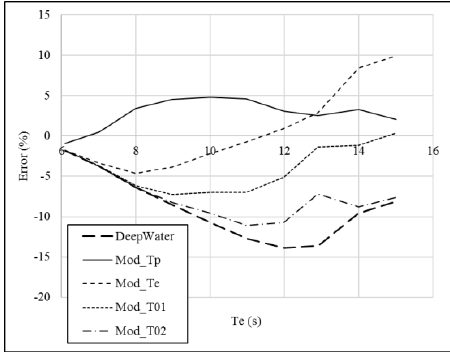
Figure 19. Errors for deep-water formulas and modifications using different periods ( h = 50 m).